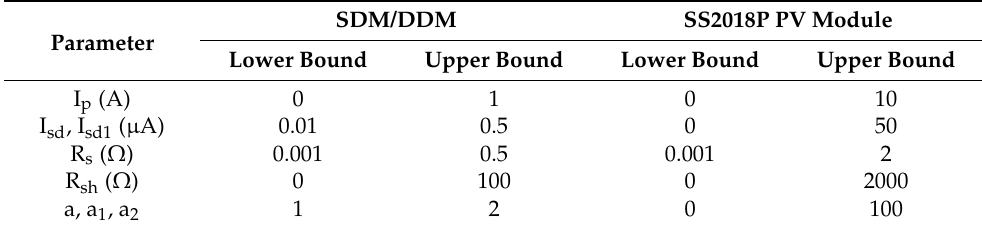
Table 1. Range of parameters for SDM, DDM and PV Module.